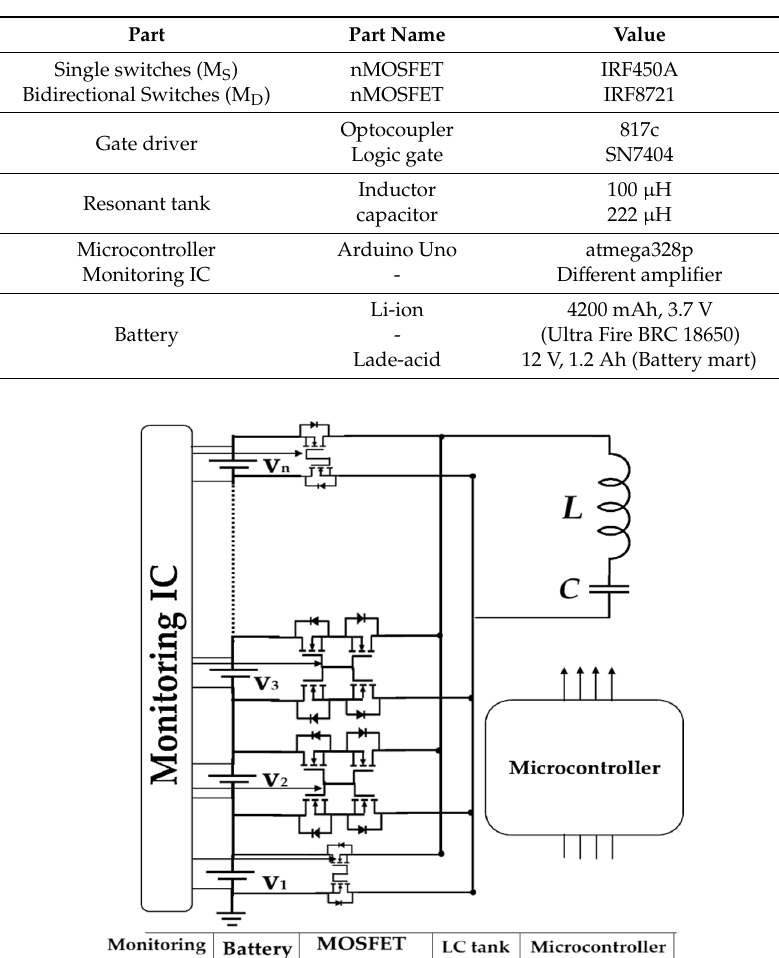
Table 1. List of the component.